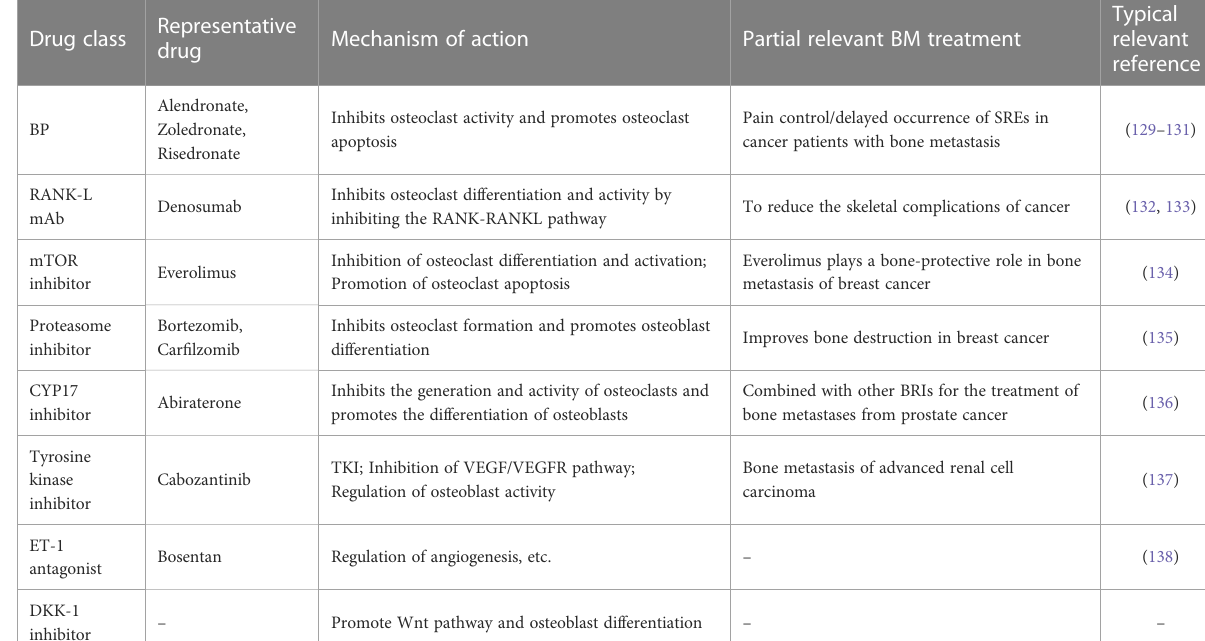
TABLE 3 Common types of bone regulatory drugs, representative drugs, related mechanisms and typical